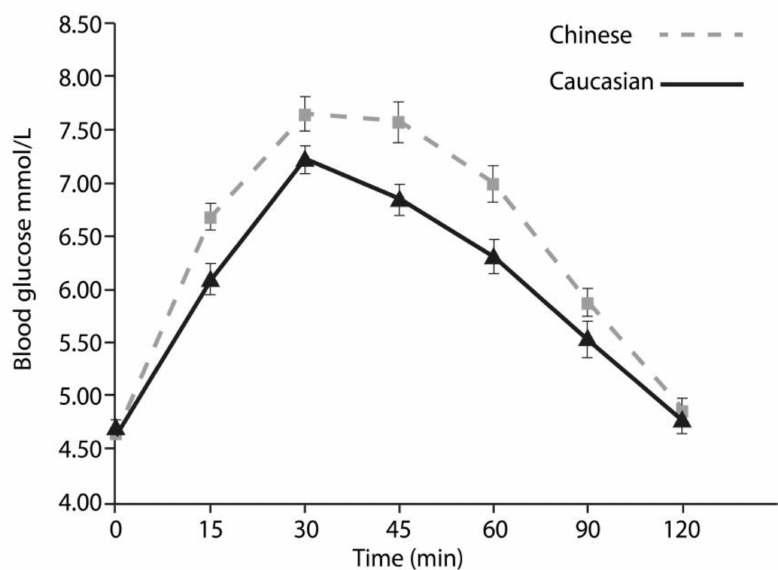
Figure 1. Represents the 2 h iAUC for glucose. The error bars represent standard error. Results are obtained from the average of two laboratory sessions ( p < 0.001) in mean blood glucose mmol/L values. Chinese ( n = 49) Caucasian ( n =